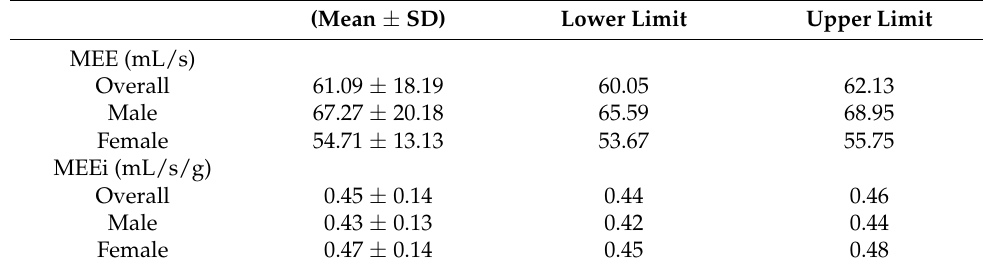
Table 3. MEE and MEEI values in the study